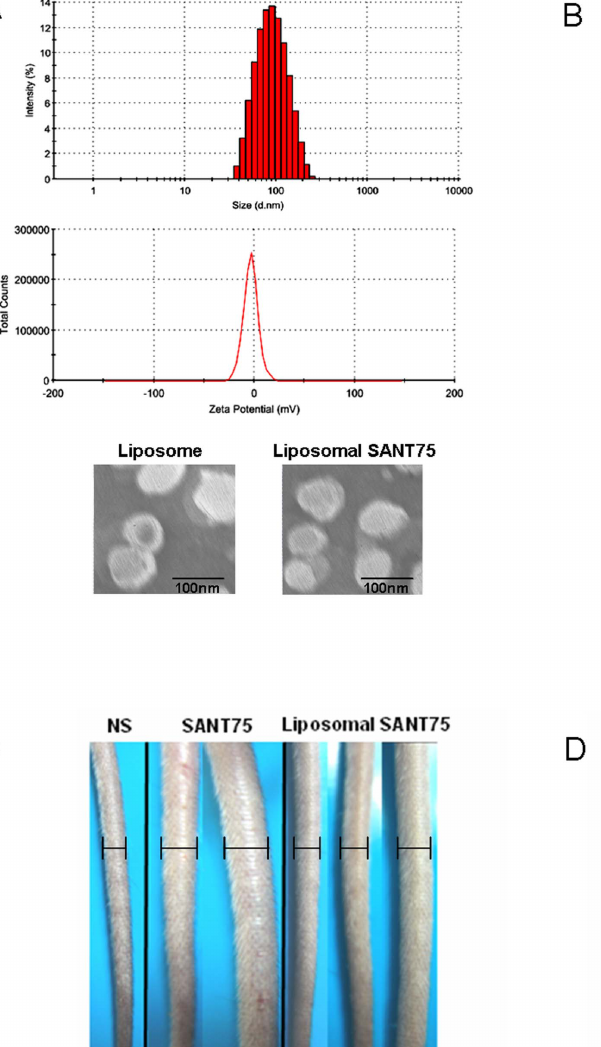
high Hh expression (6–9) were treated with various doses of liposomal SANT75. The liposomal SANT75 treatment resulted in similar antiproliferative effect compared with free SANT75. The inhibition effects were dependent on the dose of SANT75. When LL/2 cells were treated for 48 hours, the inhibition ratio of 5 m M and 20 m M liposomal SANT75 was 22% and 65.3%, respectively (Figure 4A). Similar results were found in LL/2 and other cell lines when treated them with the same dose of SANT75 (40 m M) in different formulations (Figure 4B).And there was no obvious time- dependent inhibition effect existed in LL/2 cell line when treated by liposomal SANT75 for various time intervals, which was consistent with free SANT75 (Figure S1). These data indicated that liposomal SANT75 inhibited tumor proliferation in vitro and the inhibitory efficacy was similar to free SANT75.